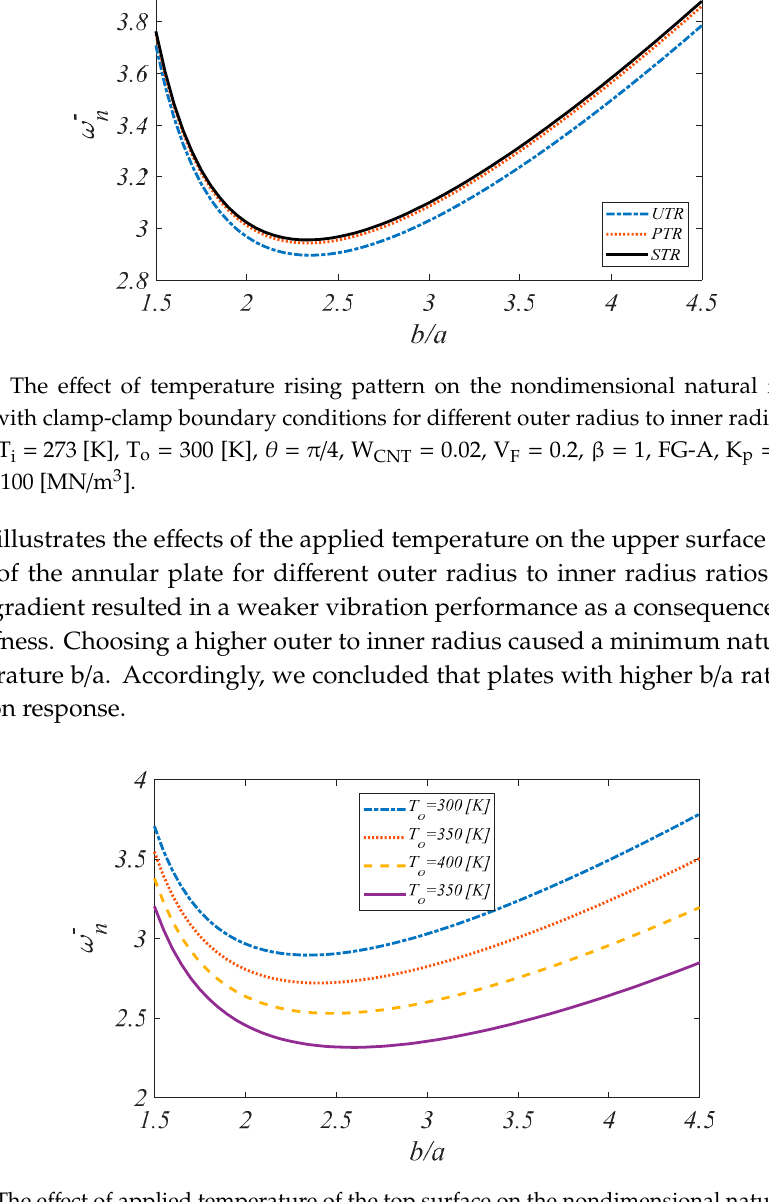
Figure 9. The effect of various volume fractions of carbon fiber on the nondimensional natural frequency of MHCAP with clamp-clamp boundary conditions for different orientation angle of carbon fibers and b/a = 4, h/b = 0.1, sinusoidal temperature rise (STR), T i = 273 [K], T o = 300 [K], W CNT = 0.02, FG-A, β = 1, K p = 10 [MN/m], and K w = 100 [MN/m 3 ]. The effects of the CNTs’ weight fraction W CNT on the vibration behavior of the annular plate with respect to different orientation angles can be found in Figure 10. An increasing W CNT improved the vibration response of the plate and was more pronounced for lower values of 𝜃 . The CNT weight fraction barely influenced the vibration performance of MHCAP when carbon fibers were arranged in an orientation of (cid:3095) (cid:2870) . Figure 11 shows the effect of the outer radius to inner radius ratio b/a on the natural frequency of the plate with and without elastic foundation and different orientation angles of carbon fibers. The effect of β involved in Equations (29) and (30) on the vibration performance of the MHCAP is